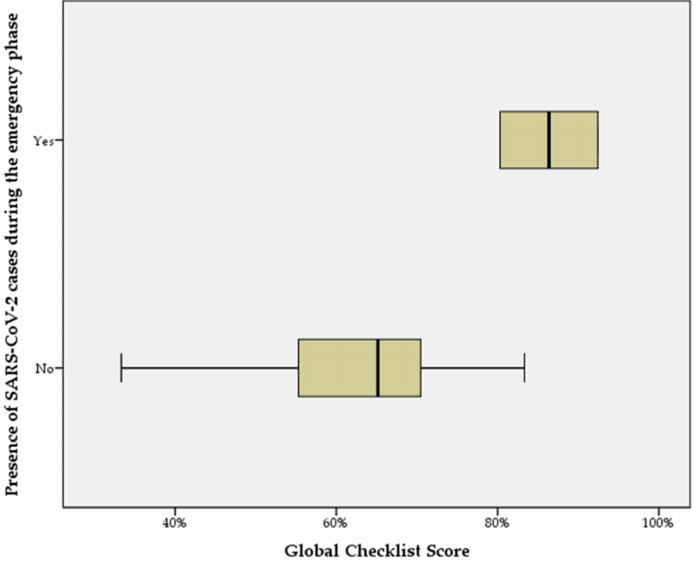
Figure 3. Distribution of total checklist scores obtained by facilities according to the presence of SARS-CoV-2 cases during the emergency